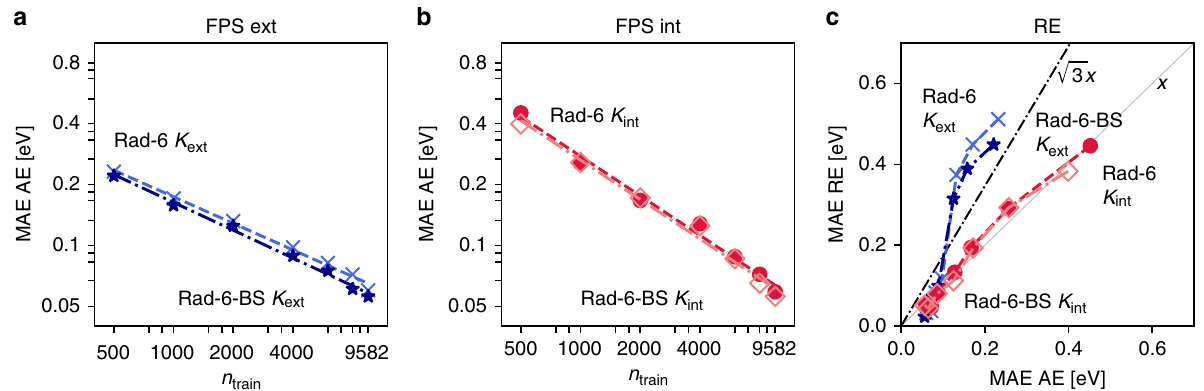
Fig. 8 Comparison ML models trained on the Rad-6 and the Rad-6-BS databases. a Learning curves for AE predictions of using the extensive kernel with an extensive FPS split and DFT geometries. b Same as ( a ) but for the intensive kernel with an intensive FPS split. c Correlation plot of MAE RE vs MAE AE for both Rad-6 and Rad-6-BS. Blue lines represent results obtained with the extensive kernel (crosses for Rad-6 and stars for Rad-6-BS) in ( a ) and ( c ). Red circles correspond to the intensive kernel with Rad-6 and orange diamonds to the intensive kernel